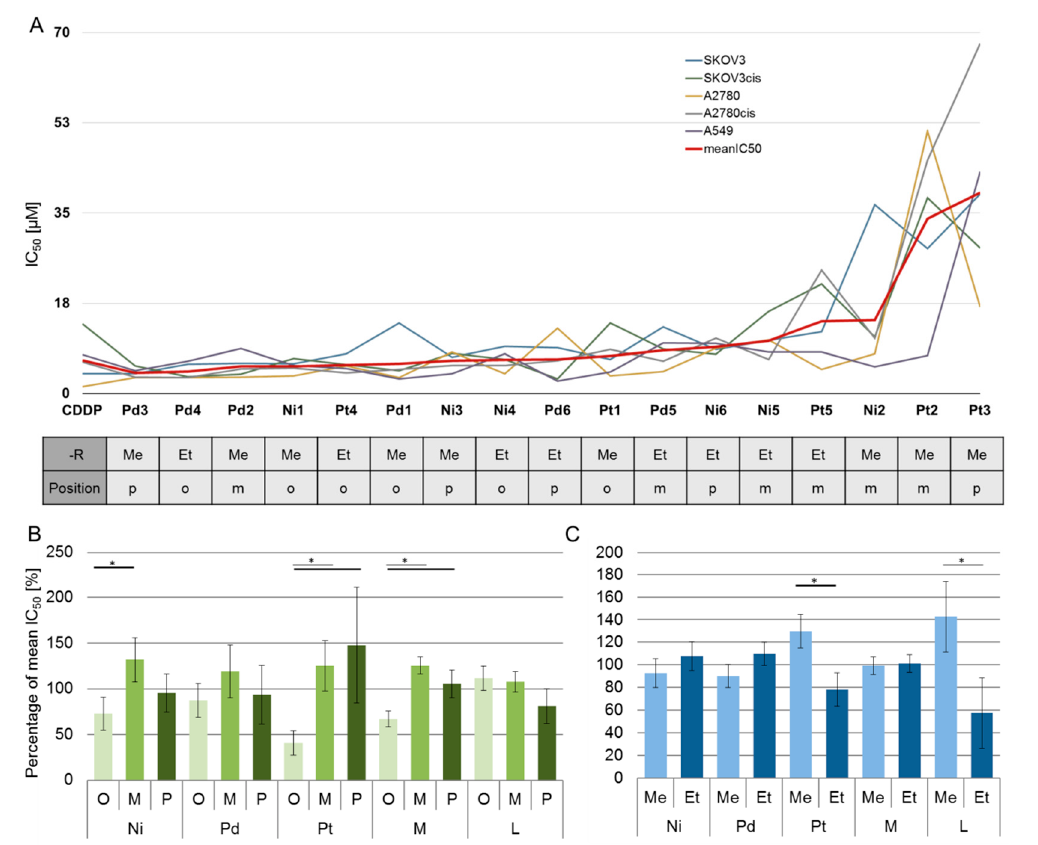
Figure 3. Structure–activity relationship for analyzed metal complexes. ( A ) : IC 50 values of all substances and CDDP for individual cell lines, and the characteristics of the compounds (metal ion; alkyl chain: Me-methoxy, Et-Ethoxy; position at phenyl ring: m-meta, o-ortho, p-para). Substances were ordered according to increasing mean IC 50 values. ( B , C ): Differences in IC 50 values for substance groups (( B )—position; ( C )—alkyl chain) relative to the mean IC 50 of all substances with otherwise identical characteristics (metal and alkyl chain ( B ) or metal and position ( C )). Depicted is the mean +/ − standard deviation for all cell lines (M—all complexes; L—ligand). Significant differences are marked with an asterisk (* p < 0.05, T-Test).